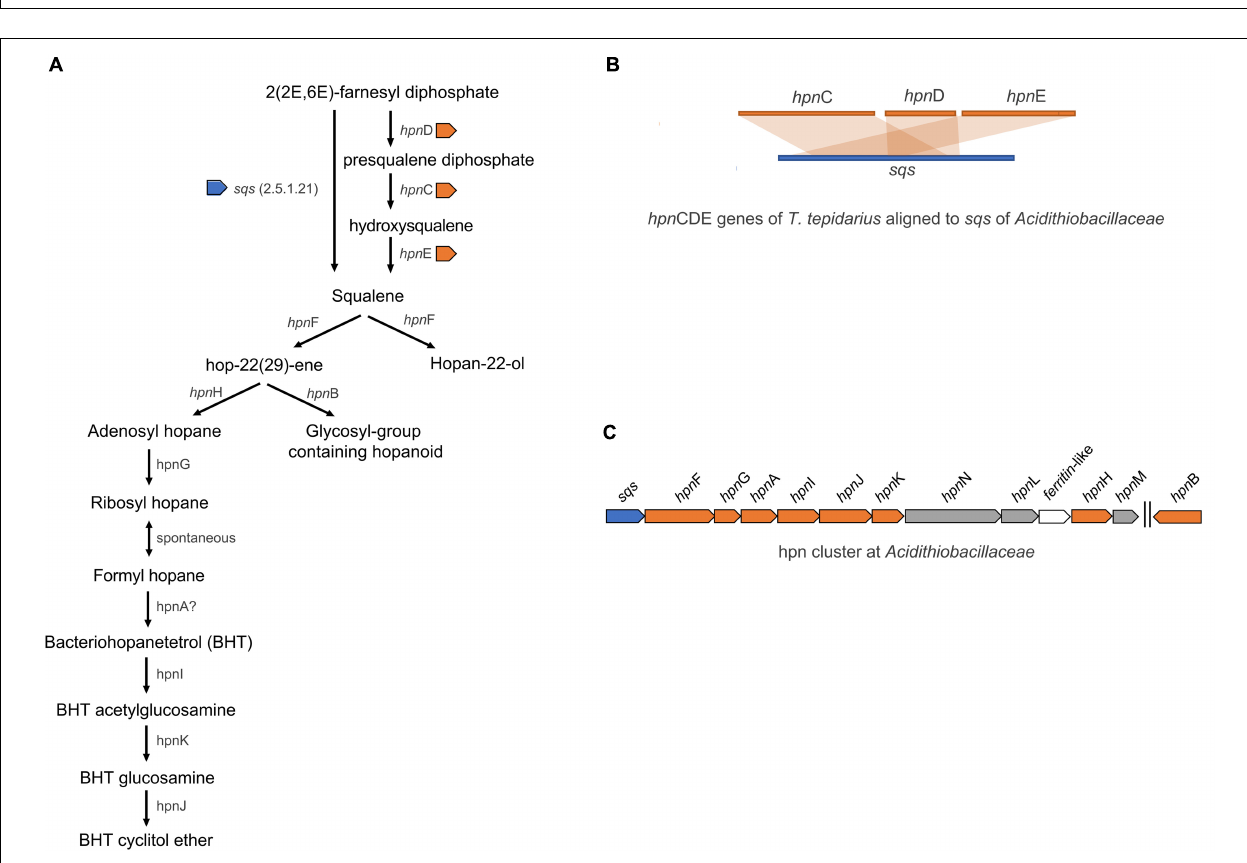
FIGURE 6 | (A) Hopanoid biosynthesis in Acidithiobacillaceae . (B) Biosynthesis of squalene, that is required for hopanoid, is synthetized by sqs in acidophiles in contrast to hpn CDE in the neutrophile T. tepidarius . (C) The hpn cluster was identified in Acidithiobacillaceae including sqs- hpn FGAIJKNL- ferritin - hpn HM genes.